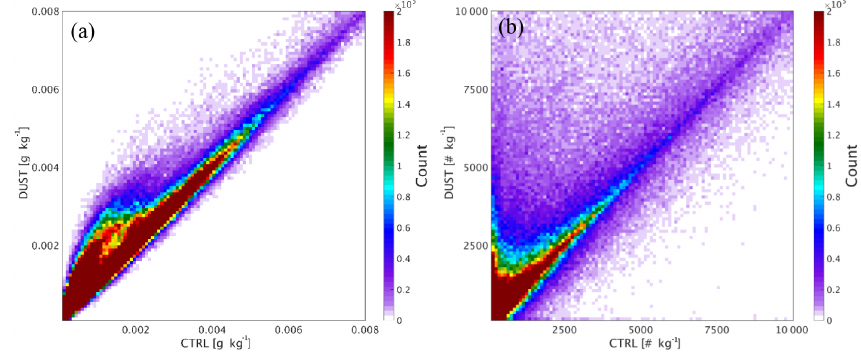
Figure 6. 2-D histogram of simulated cloud ice mixing ratio (a) and cloud ice crystal number concentration (b) from CTRL and DUST. The color scales indicate the number of grid points in specific value bins of ice mixing ratio and ice crystal number concentration.